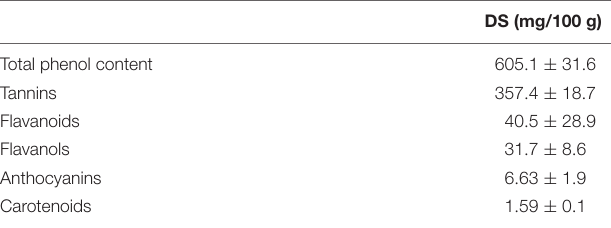
TABLE 1 | Antioxidant determination of date syrup